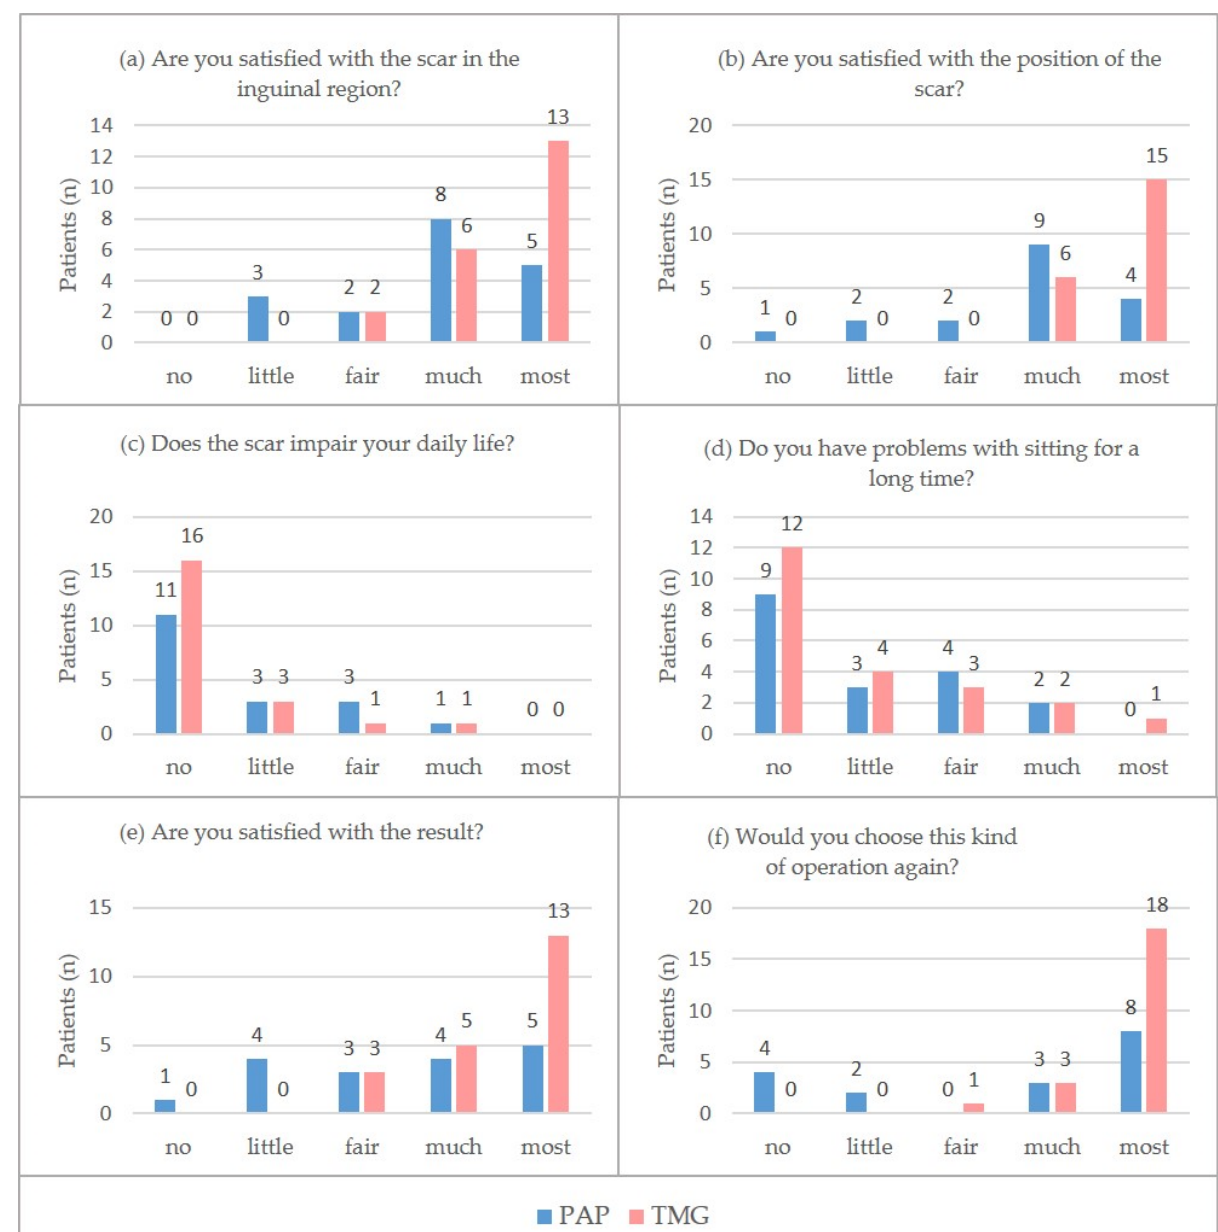
Figure 2. ( a – e ). Questions about the donor-site and breast reconstruction, “no answer” excluded. Figure 2. ( a – f ). Questions about the donor-site and breast reconstruction, “no answer”